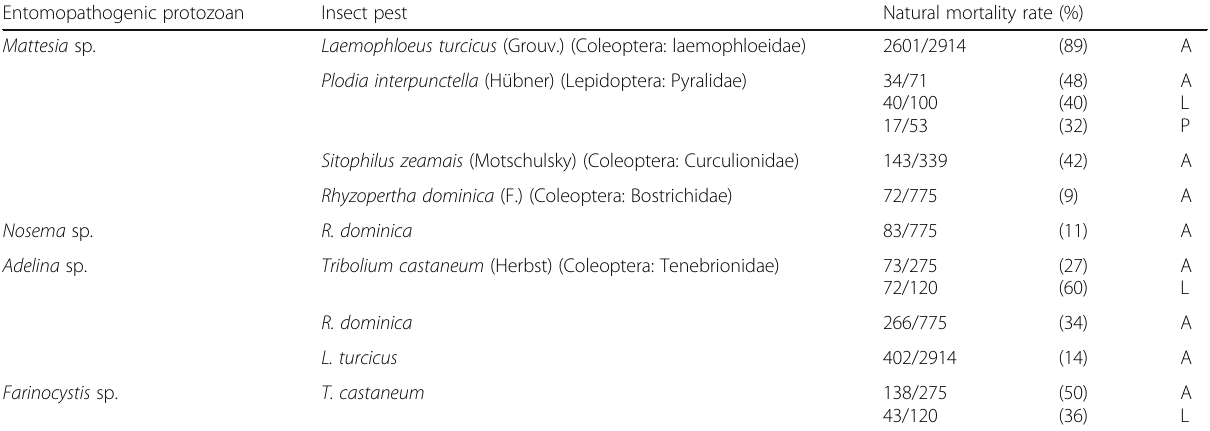
Table 1 Natural mortality rates (%) among certain insect pests of stored grain due to entomopathogenic protozoans Entomopathogenic protozoan Insect pest Natural mortality rate (%) Mattesia